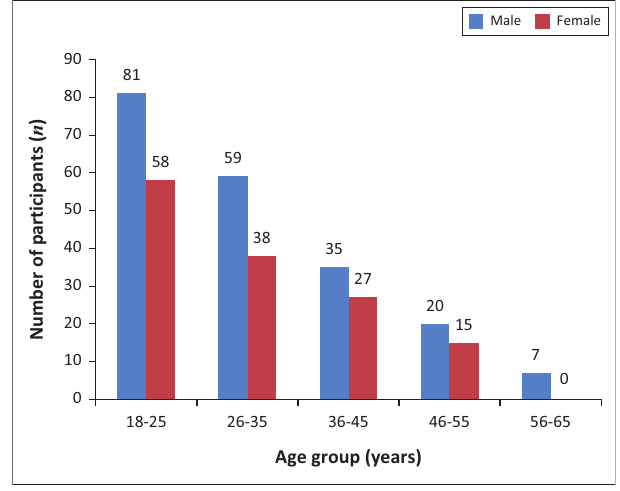
FIG URE1: Percentage distribution of age group (years) and sex of participants in the blood donor population of Bamenda, Cameroon, April-